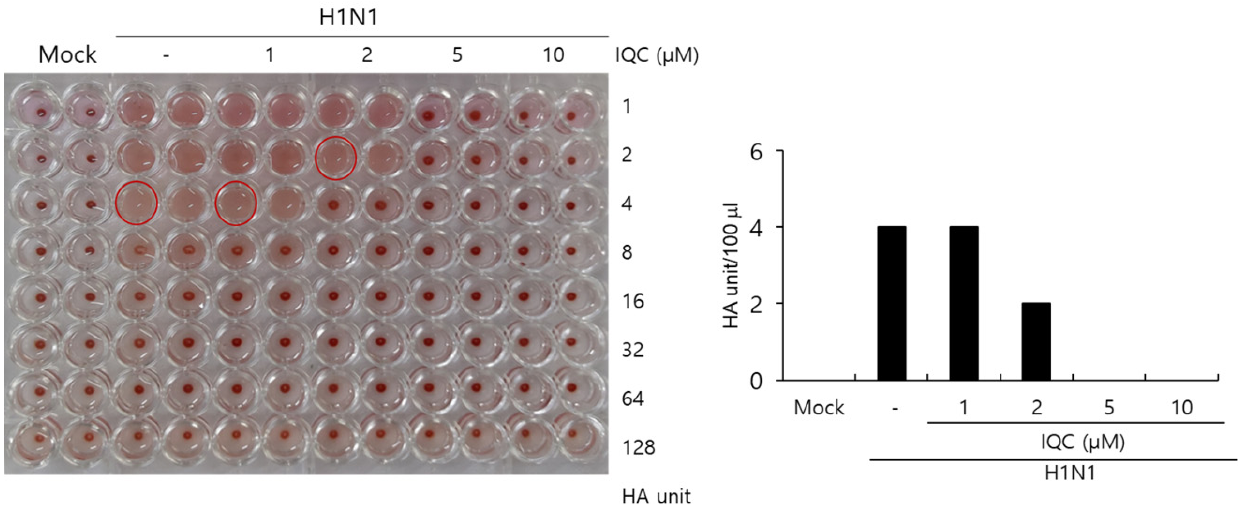
Figure 5. Isoquercitrin inhibits hemagglutination upon IAV infection. ( A , B ) H1N1 IAV at 10 MOI and IQC at concentrations of 0, 1, 5, 10, or 25 µM were mixed for 1 h at 4 °C . Each mixture was added to the RAW 264.7 cells for 2 h. After washing with PBS, the cells were further incubated for 24 h. The supernatants of cells were serially 2-fold diluted and mixed with 1% RBC cells to investigate the effect of IQC on hemagglutination by IAV infection.